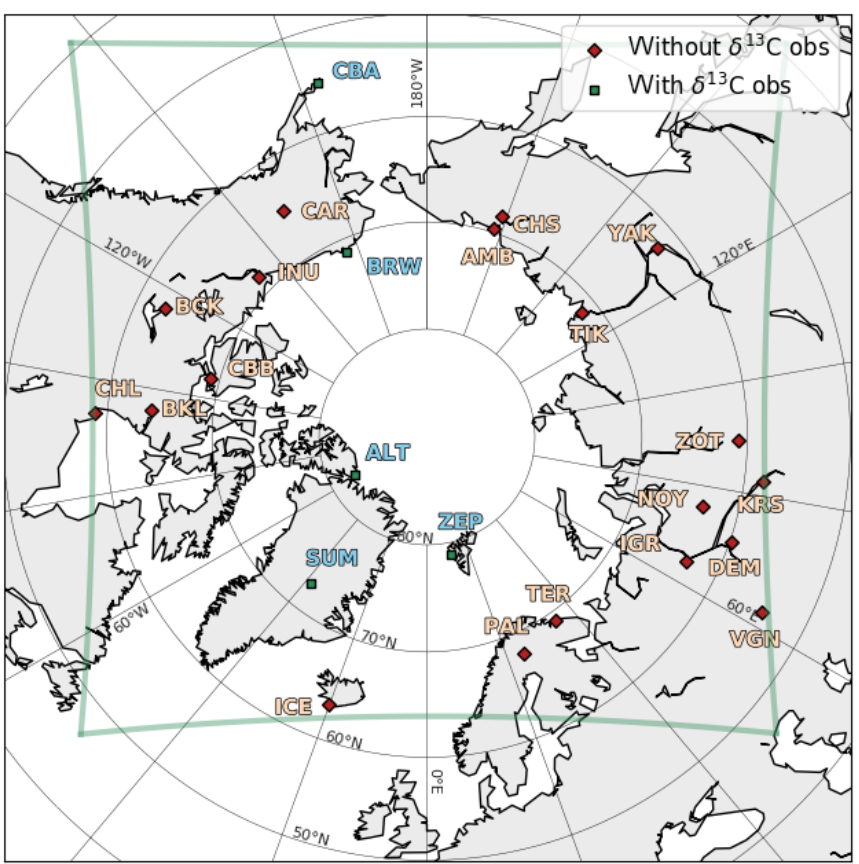
Figure 1. Delimitation of the studied polar domain (green line), the location of the 24 measurement sites used in this study and measuring atmospheric methane. Five stations (blue squares) include flask measurements of δ 13 C CH4 . The station name abbreviations are given in